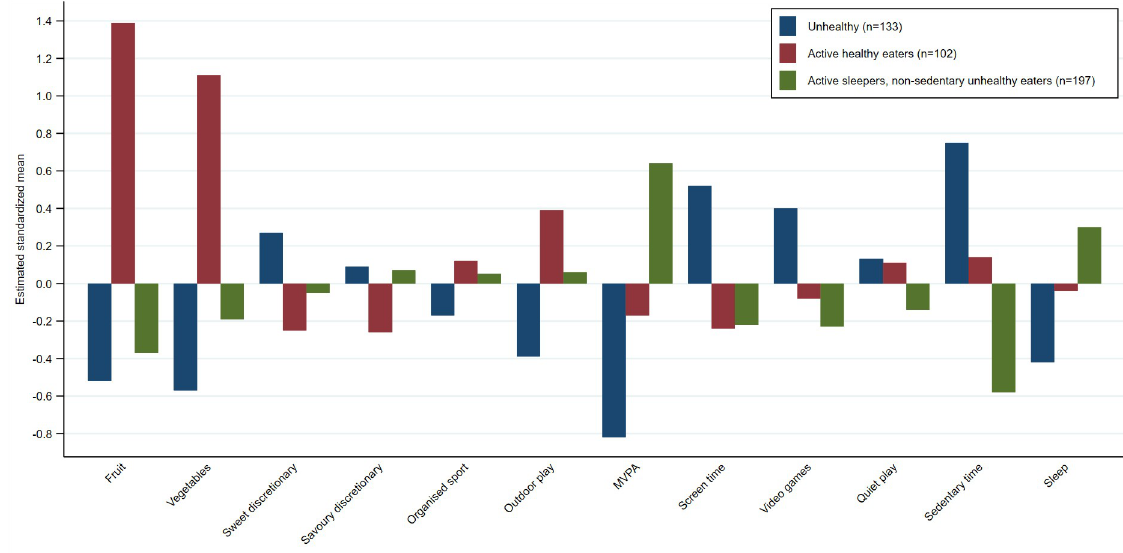
Fig 1. Average value of the standardized input variables for each behavioural pattern derived using K-means cluster analysis. Footnote: n; number of children in each pattern.